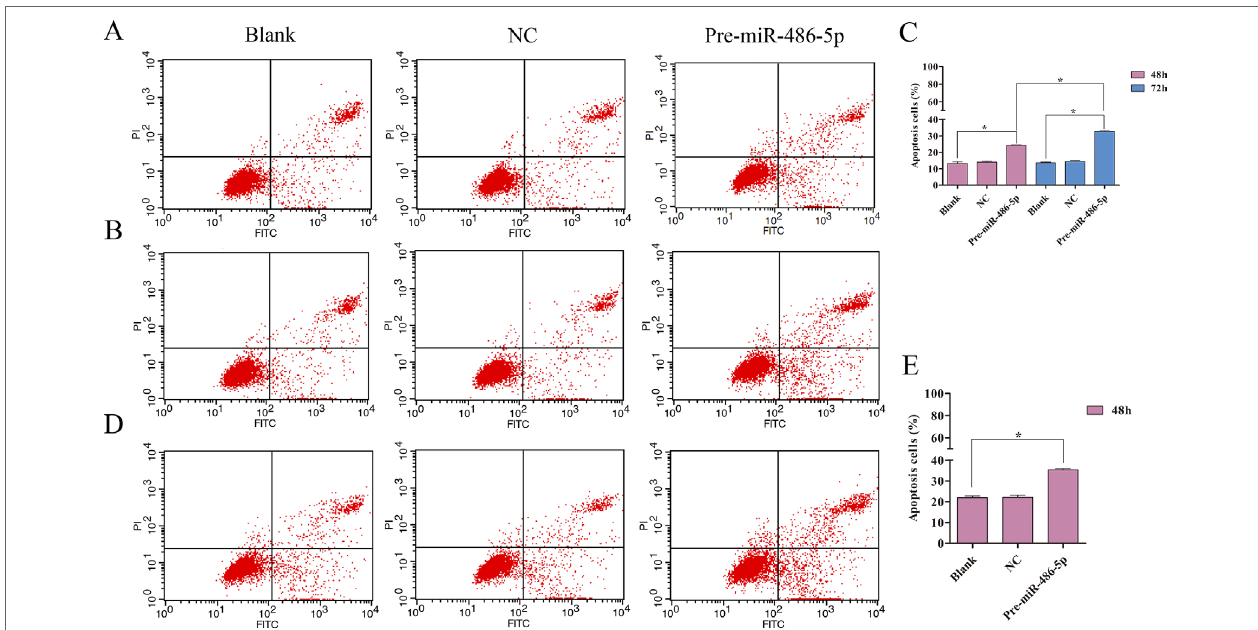
FIGURE 7 | Overexpressed miR-486-5p significantly induced A549 and H1299 cell apoptosis. (A , B) A549 cells were stained with annexin V fluorescein isothiocyanate (V-FITC) and propidium iodide (PI) after 48 h (A) and 72 h (B) incubation. One representative experiment was shown, and similar results were obtained in three independent experiments. (C) The percentage of A549 apoptosis cells were shown after 48 and 72 h incubation, respectively. (D) One representative experiment was shown in H1299 cell apoptosis after 48 h with transfection. (E) The percentage of H1299 apoptosis cells were shown after 48 h incubation. * p <